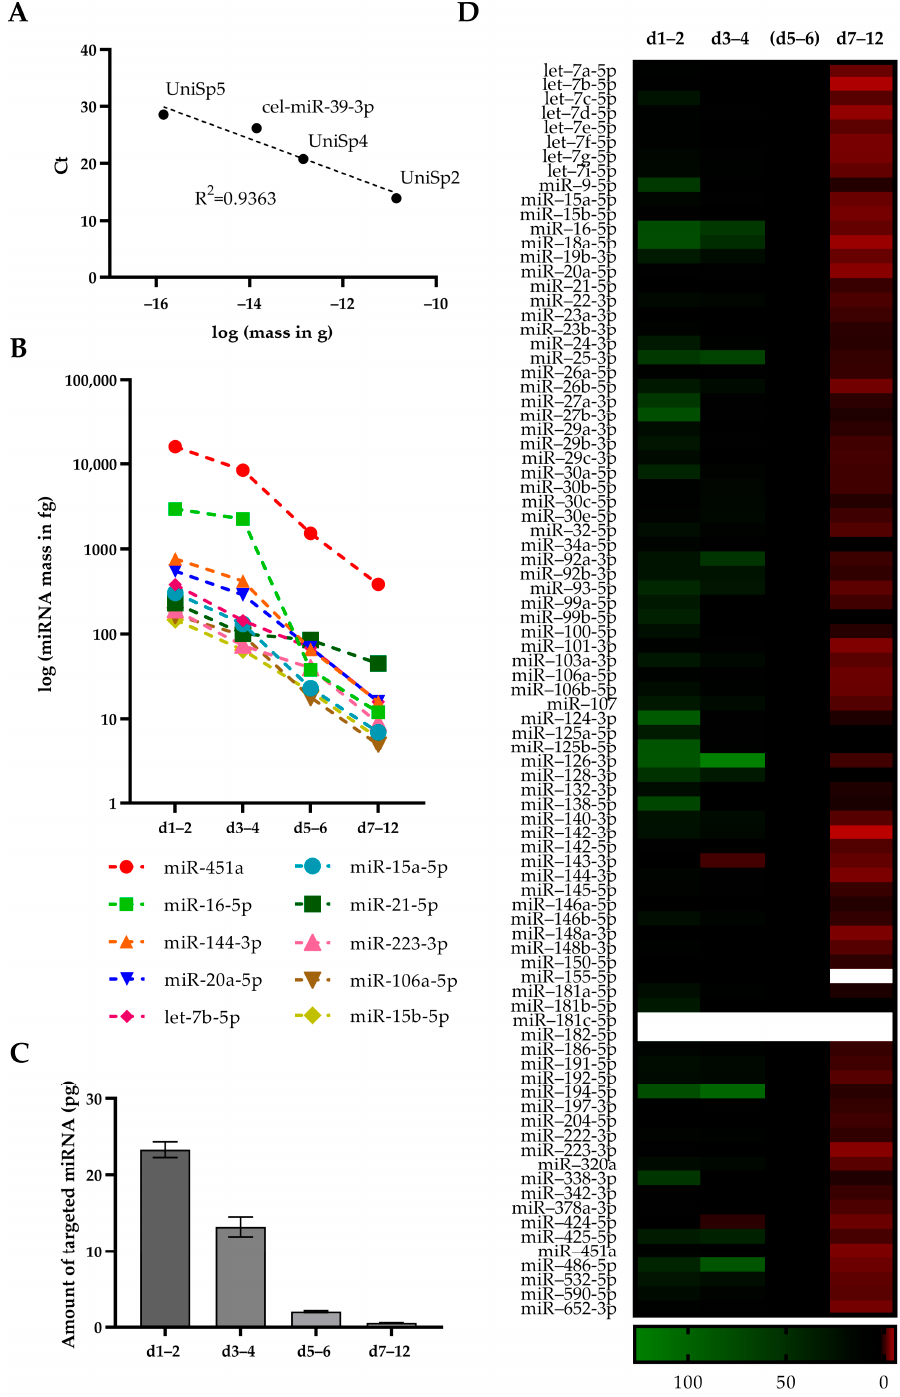
Figure 3. Targeted microRNAs (miRNAs) are abundant in the early days after severe traumatic brain injury (sTBI). ( A ) Absolute quantification of targeted miRNAs was performed by standard curves obtained by applying four miRNA spike-ins of pre-defined concentrations. Spike-ins were amplified simultaneously with targeted miRNAs on a PCR-array followed by plotting spike-in amounts against obtained cycle thresholds (Ct). A representative plot is shown. ( B ) Spike-in con- taining cDNAs from cerebrospinal fluid (CSF) pools of indicated days (d) after sTBI were analysed